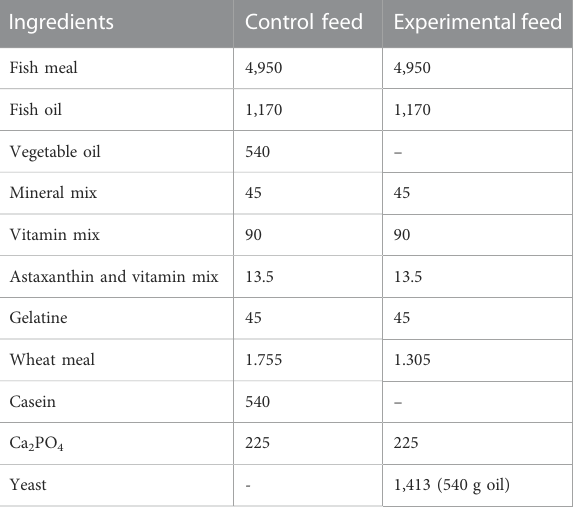
TABLE 1 Composition of control and experimental yeast feeds (g kg − 1 ) for fi sh in duplicates. “ Vitamin mix ” and “ Mineral mix ” ingredients were provided by NOFIMA (Norway) and “ astaxanthin and vitamin mix ” ingredients were provided by Aller Aqua A/S (Denmark) appear below.